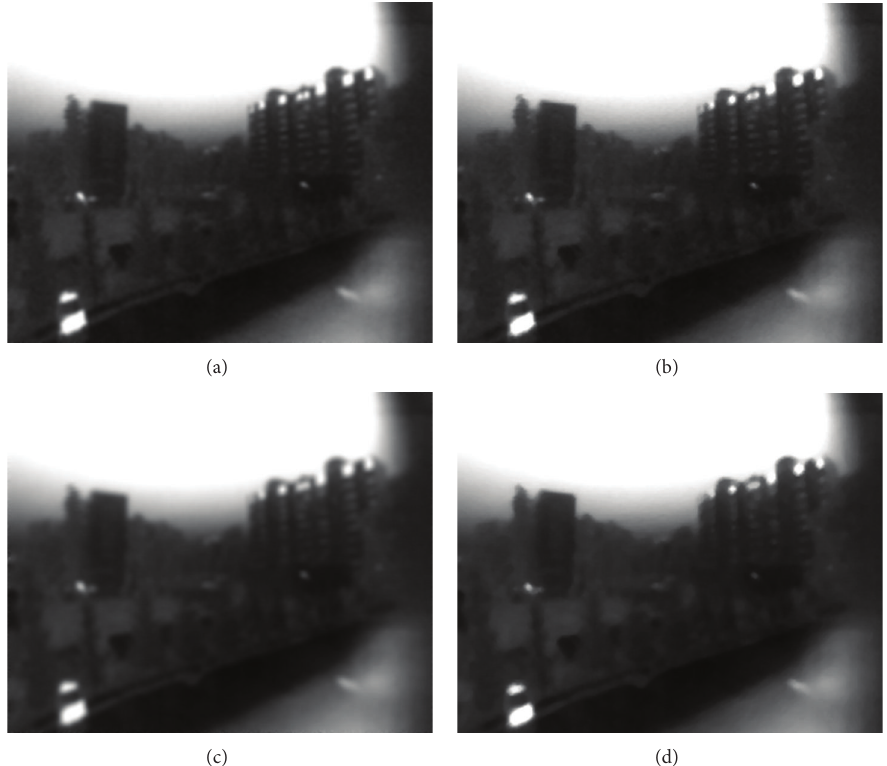
Figure 7: (a) Denoised KUT25 WSS (3 × 3 averaging filter), (b) denoised KUT25 WSS (3 × 3 median filter), (c) denoised KUT25 WSS (5 × 5 averaging filter), and (d) denoised KUT25 WSS (5 × 5 median